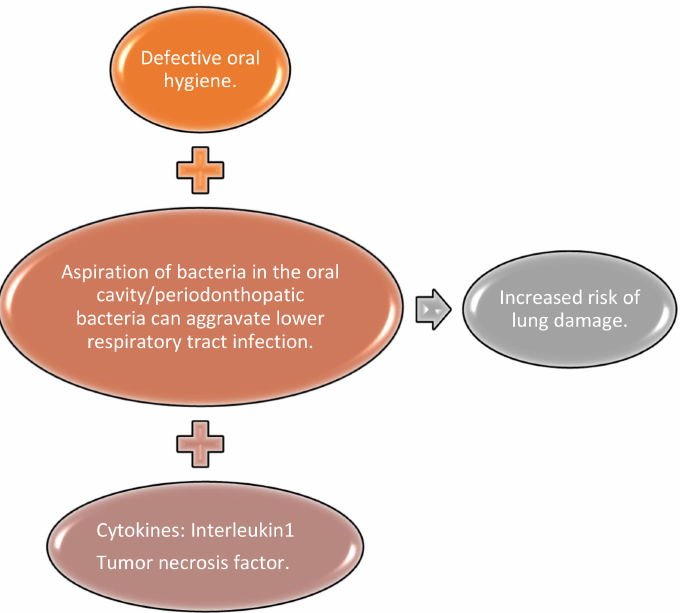
Figure 2. The link between poor oral hygiene, bacteria present in the oral cavity, and increased risk of lung